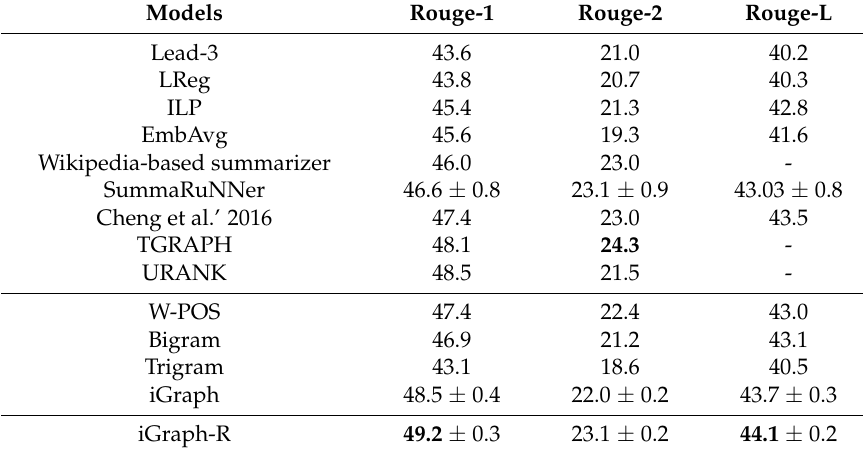
Table 2. The Rouge score (%) of various models on DUC 2002 using the limited length recall variants of Rouge at 100 words. Word part-of-speech (POS) pairs similarity = W-POS; Bigram similarity = Bigram; Trigram similarity = Trigram; The integration of three types of graphs = iGraph; The iGraph with the redundancy removal =